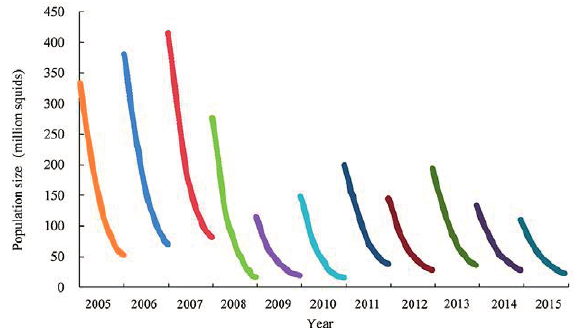
Fig. 7. – Annual initial (1 August) and final (30 November) abun- dance (million individuals) of the western winter-spring stock of Ommastrephes bartramii from 2005 to 2015 estimated from the DeLury depletion model based on M =0.007 per day.